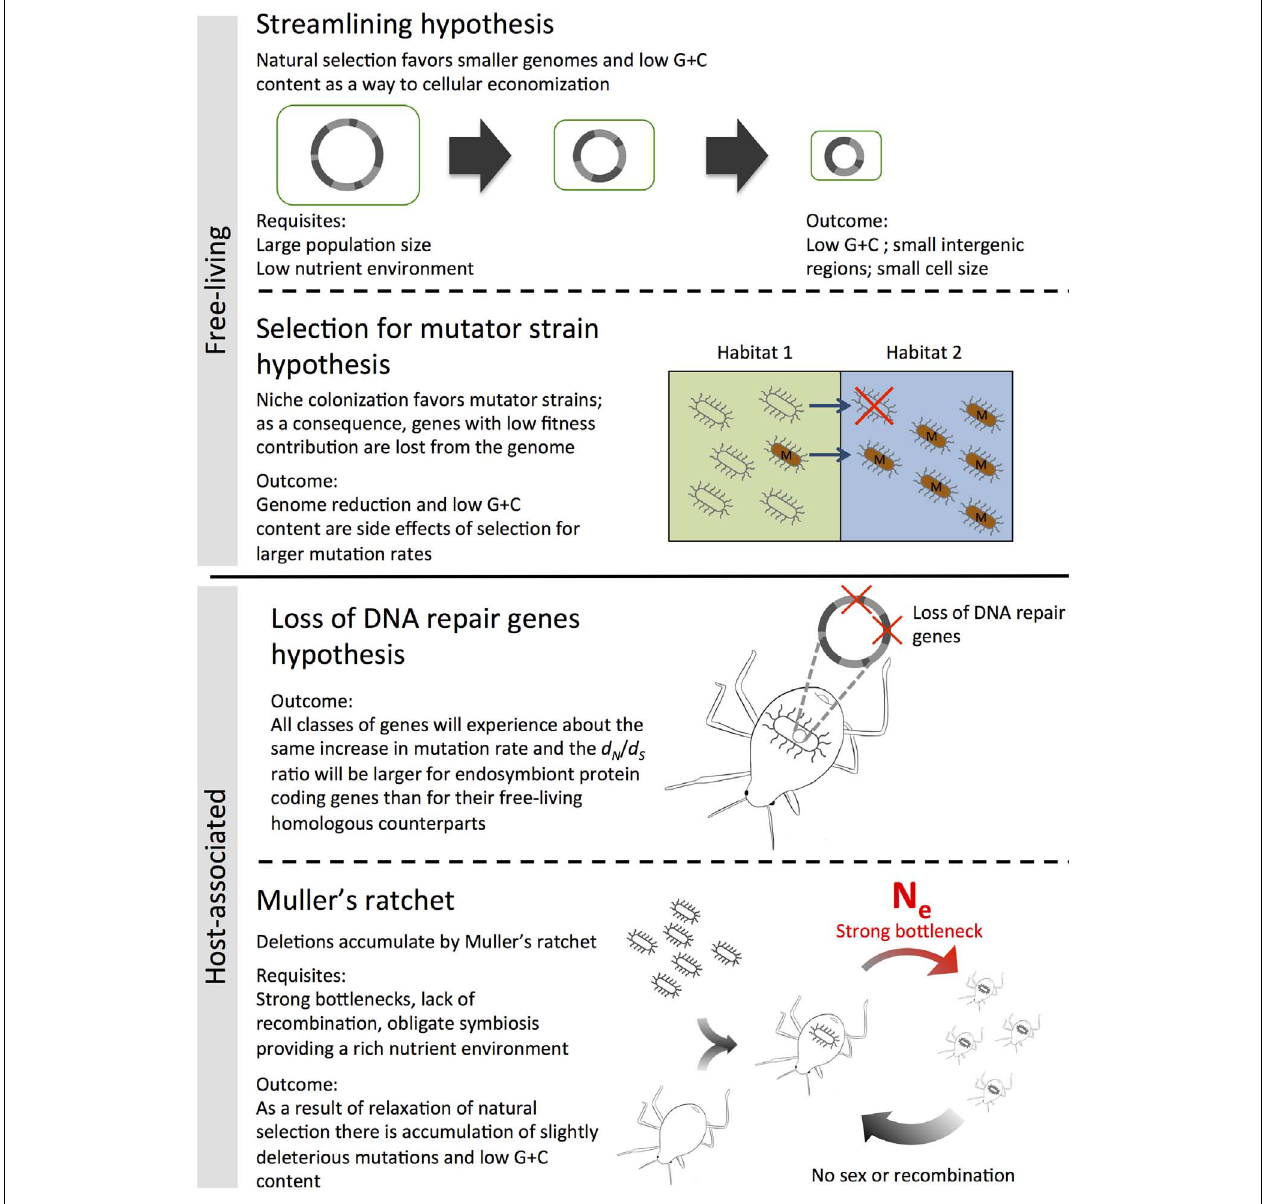
FIGURE 1 | Streamlining and Muller’s ratchet hypotheses are commonly used to explain genome reduction in free-living and host-associated bacteria respectively. Alternative hypotheses include “selection for mutator strains” and “loss of DNA repair